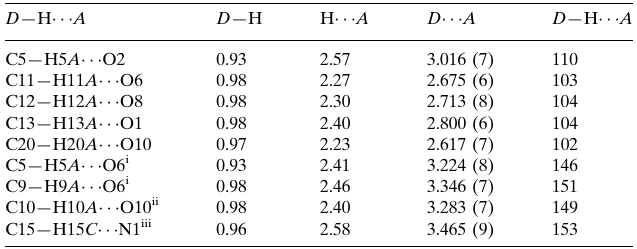
Hydrogen-bond geometry (A˚ , (cid:4)